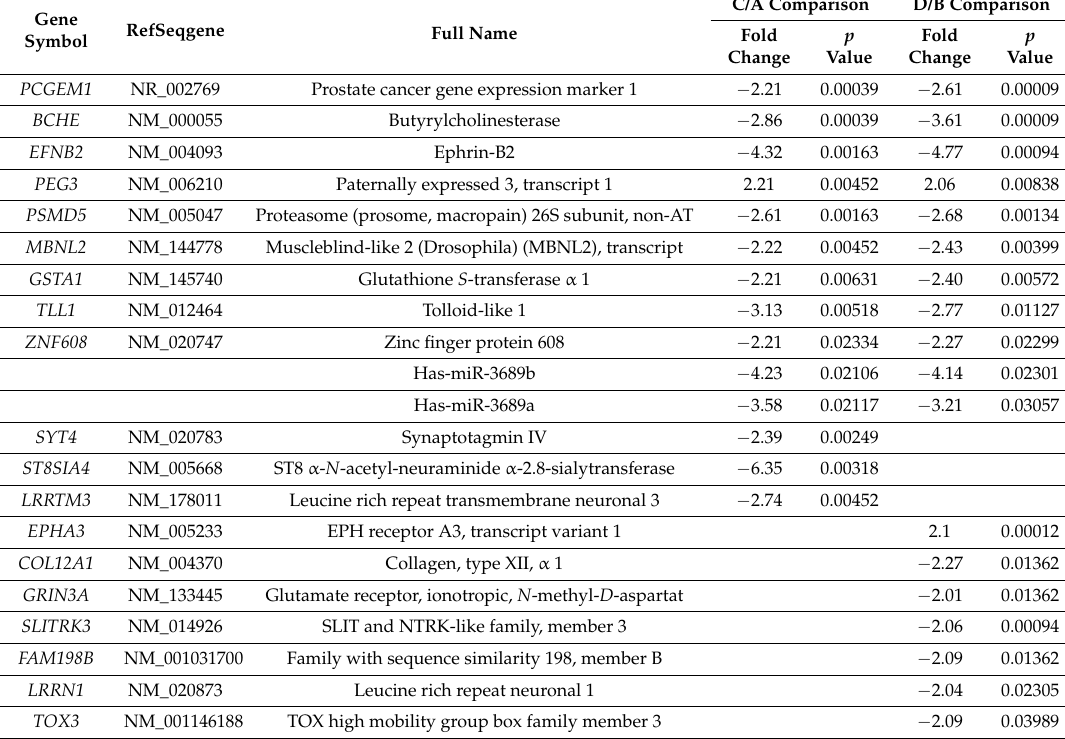
Table 1. Genes and microRNAs regulated by type 3a AR in LNCaP cells as revealed by microarray analysis using the Affymetrix Gene Array